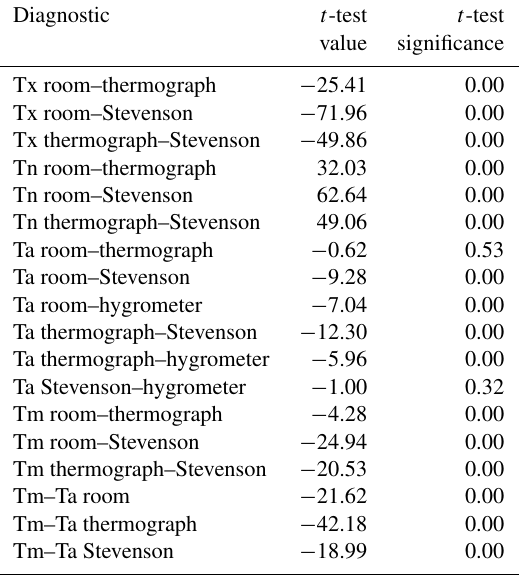
Table 2. The t -test results for various comparisons using a paired t test. With the exceptions of the calculated averages for the well- ventilated room (06:00 and 15:00LST) and thermograph (average of 24h) as well as the Stevenson screen and hygrometer (both 06:00 and 15:00LST) (both bolded), all remaining comparisons of indi- vidual temperature indicators across instruments are highly signifi- cant. Also significant are the differences between average tempera- tures (06:00 and 15:00LST or 24h) and mean temperatures (aver- age of Tx and Tn) for the three instruments that report